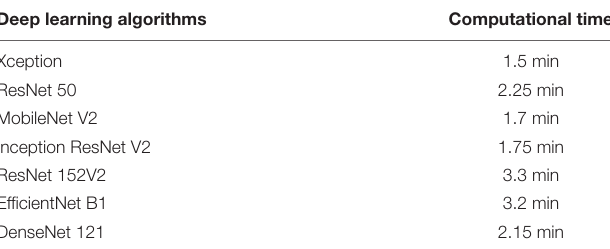
TABLE 5 | Comparison of various deep learning